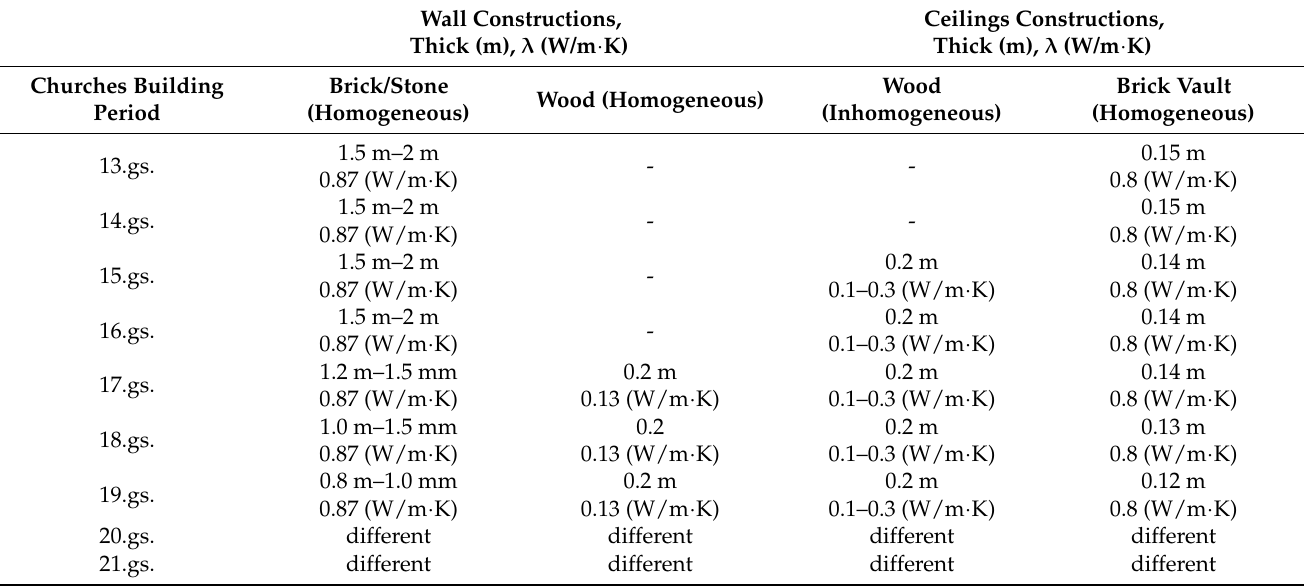
Table 3. Types and dimensions of enclosures by period of construction.